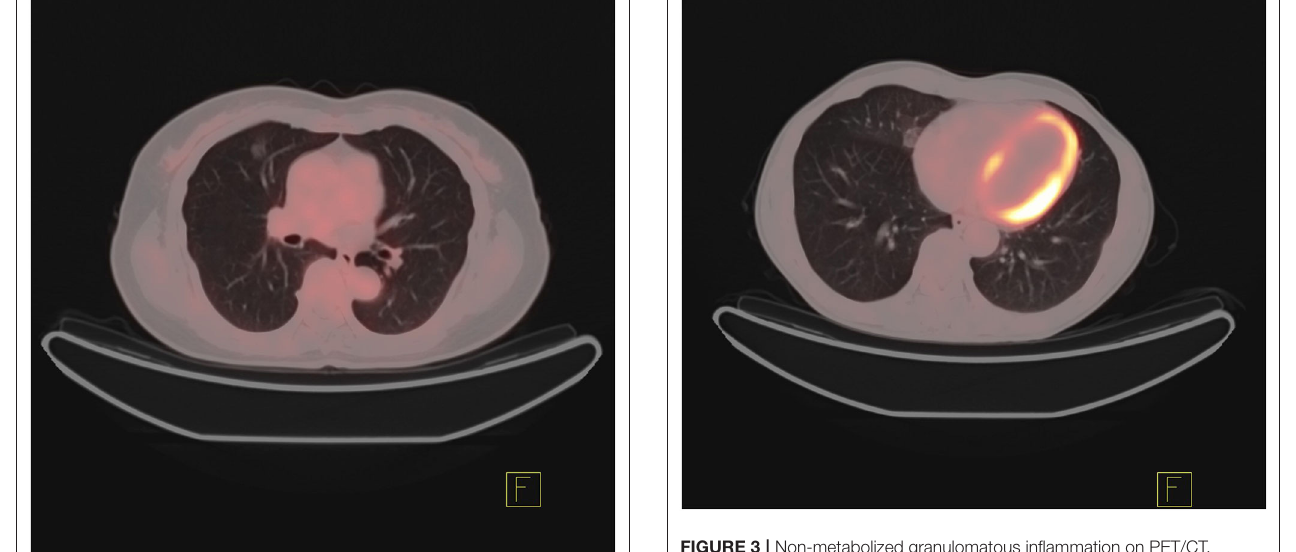
FIGURE 3 | Non-metabolized granulomatous inflammation on